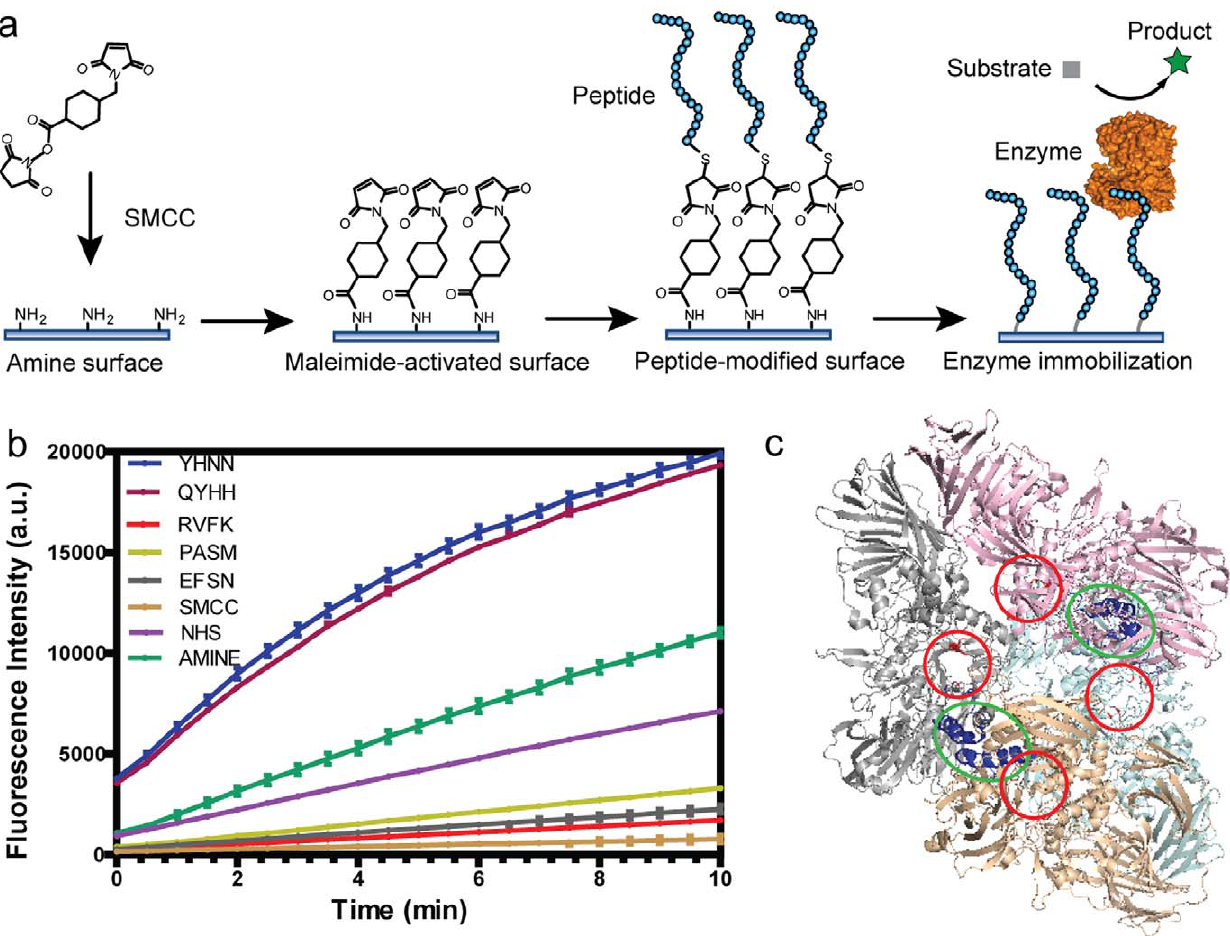
Figure 1. Enzyme immobilization on peptide-modified surfaces. (a) The overall process for conjugating peptides to aminated microwells through specific reactions between C-terminal cysteines and maleimide-activated surfaces. (b) Activity of b -Gal immobilized on different surfaces. 25 nM b -Gal is first incubated with modified microwells for one hour and then enzyme activity is measured at 25 u C as a function of time using 100 m M Resorufin b -D-galactopyranoside as the substrate. YHNN, QYHH, RVFK, PASM and EFSN represent b -Gal bound to various peptide-modified surfaces (see text). SMCC and NHS represent enzyme covalently bound via thiol and amine conjugation, respectively. AMINE represents enzyme bound noncovalently to an aminated surface. (c) Proteolytic mapping of peptide binding to tetrameric b -Gal with binding regions circled (Green). Each subunit is labeled with a unique color showing the symmetry of the b -Gal structure. The binding regions (amino acids 419–447) are highlighted in blue. The substrate-binding sites of b -Gal are circled with right color (Glu461, Met502, Tyr503 and Glu537) according to reference 16.